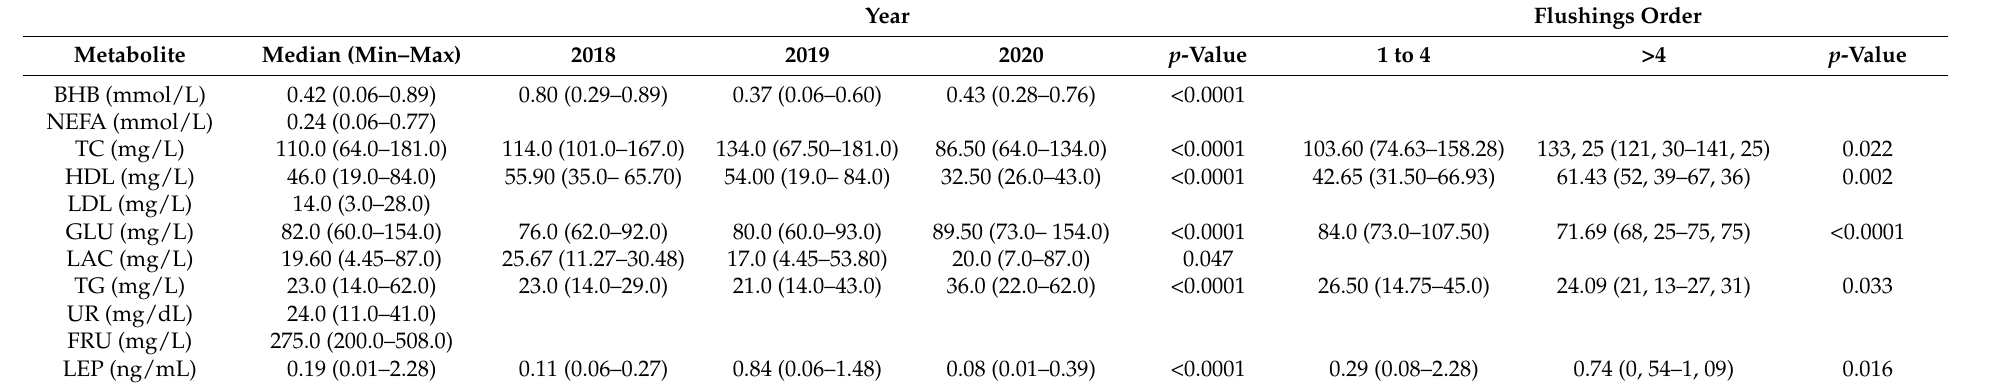
Table 1. Donor blood plasma metabolites at embryo flushing and factors affecting Japanese Black heifers submitted to a MOET program at a Spanish